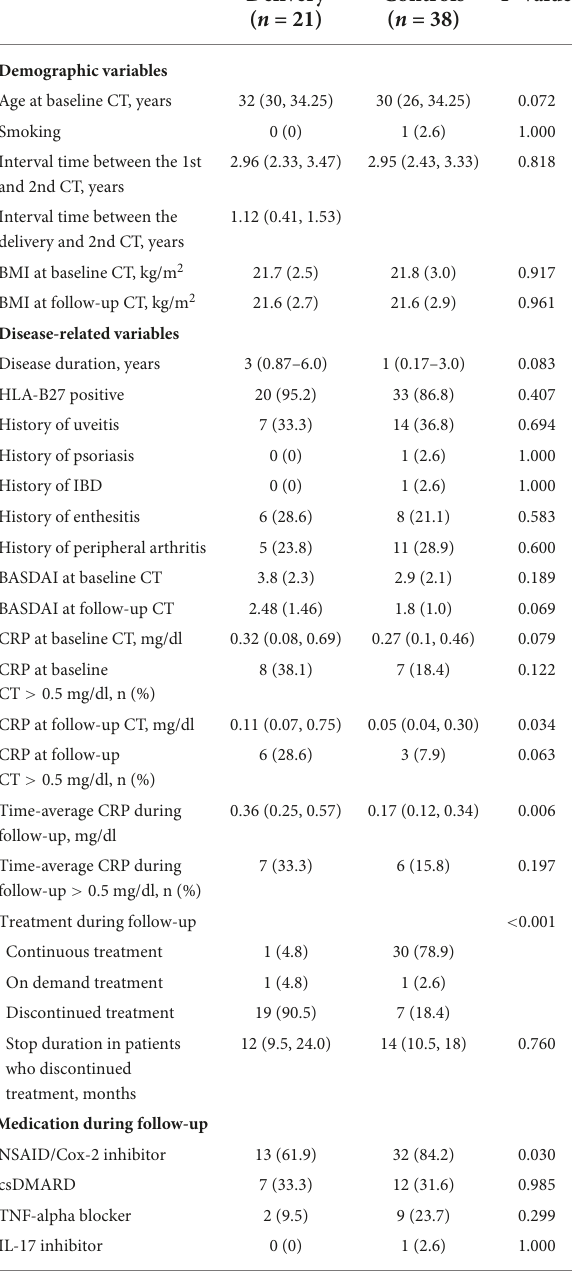
TABLE 1 Baseline characteristics of women with r-axSpA included in the analyses.